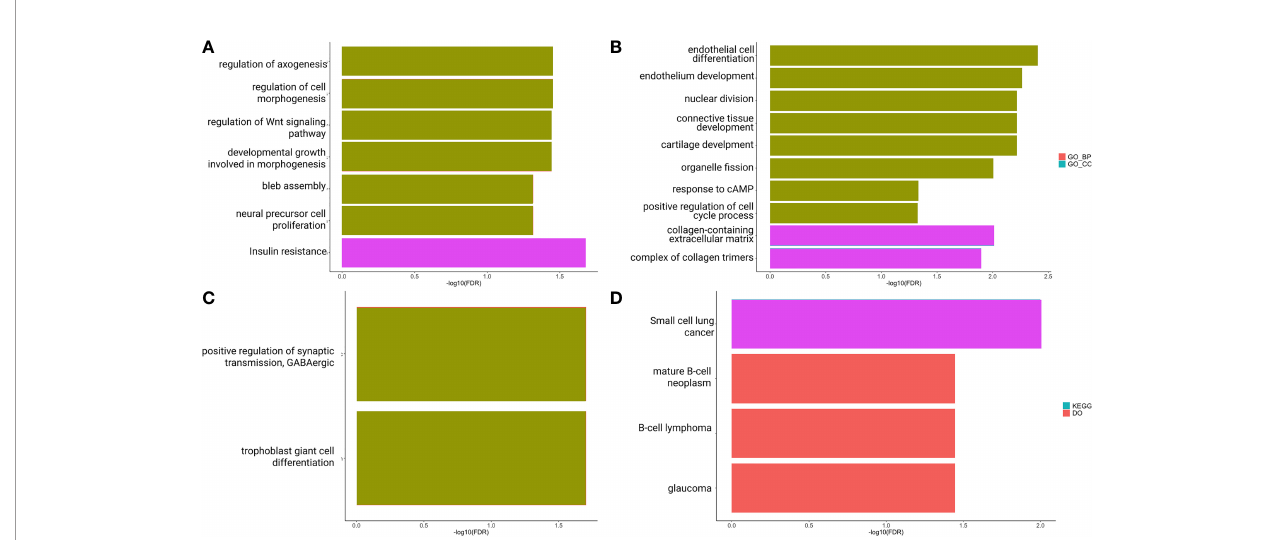
FIGURE 5 | Functional enrichment analysis of PCGs and lncRNAs included in the ceRNA network: common to colon, rectum and rectosigmoid junction (A) ; speci fi c to colon (B) ; speci fi c to rectum and (C) ; speci fi c to rectosigmoid junction (D) sites.